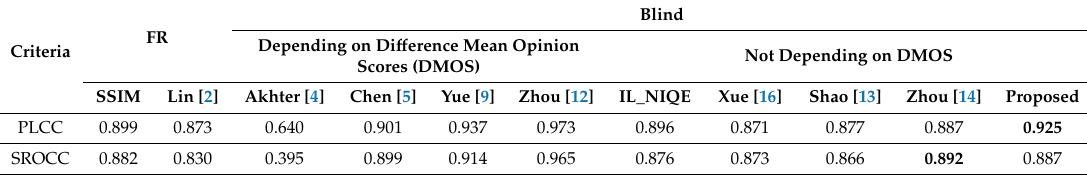
Table 1. Overall performance evaluation of nine methods.